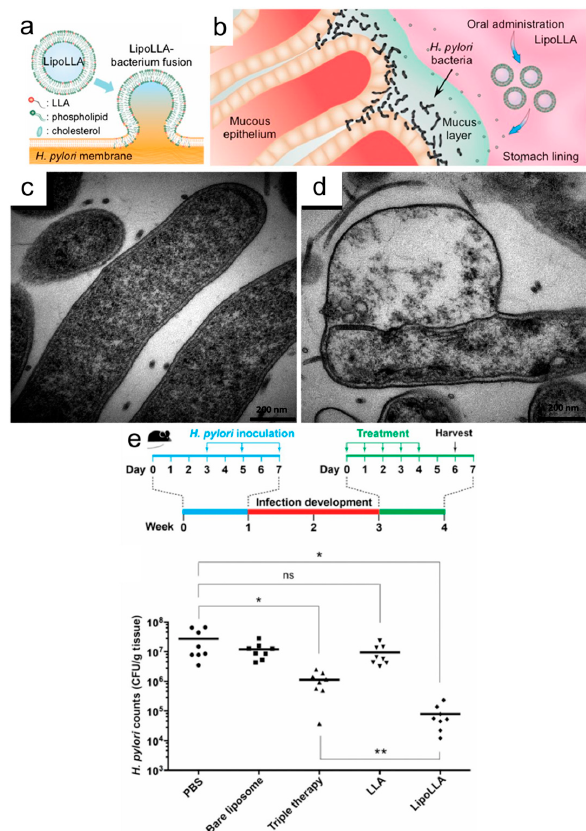
Figure 4. ( a ) Fusion of fatty acid-loaded liposomes with bacterial cell membranes; ( b ) liposomal delivery to H. pylori -infected stomach lining; TEM micrographs of ( c ) control and ( d ) LipoLLA-treated H. pylori bacteria; ( e ) bacterial load of H. pylori in mouse stomach after treatment with different therapeutic agents. * p < 0.05, ** p < 0.001. Reproduced with permission from Refs. [64,66].